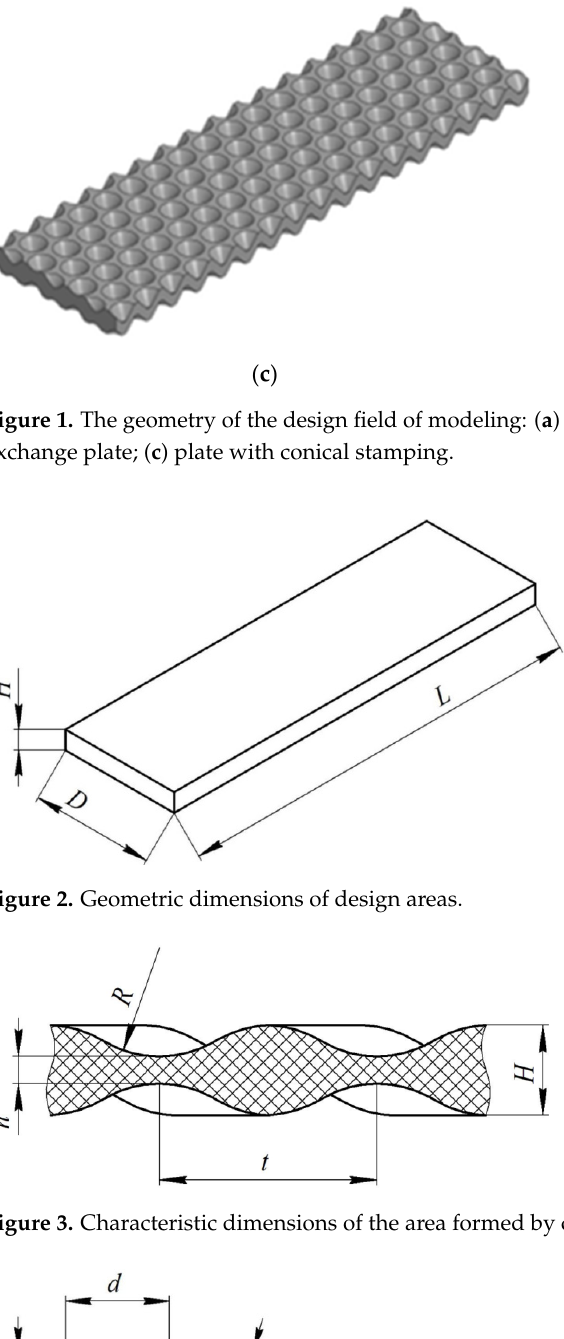
Figure 3. Characteristic dimensions of the area formed by chevron heat exchange plates.